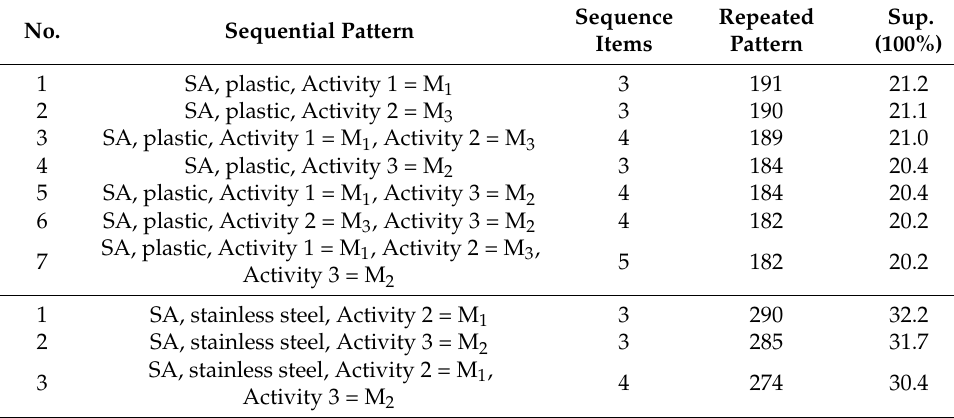
Table 14. Frequent sequential patterns for machine type = SA and the material of drum.